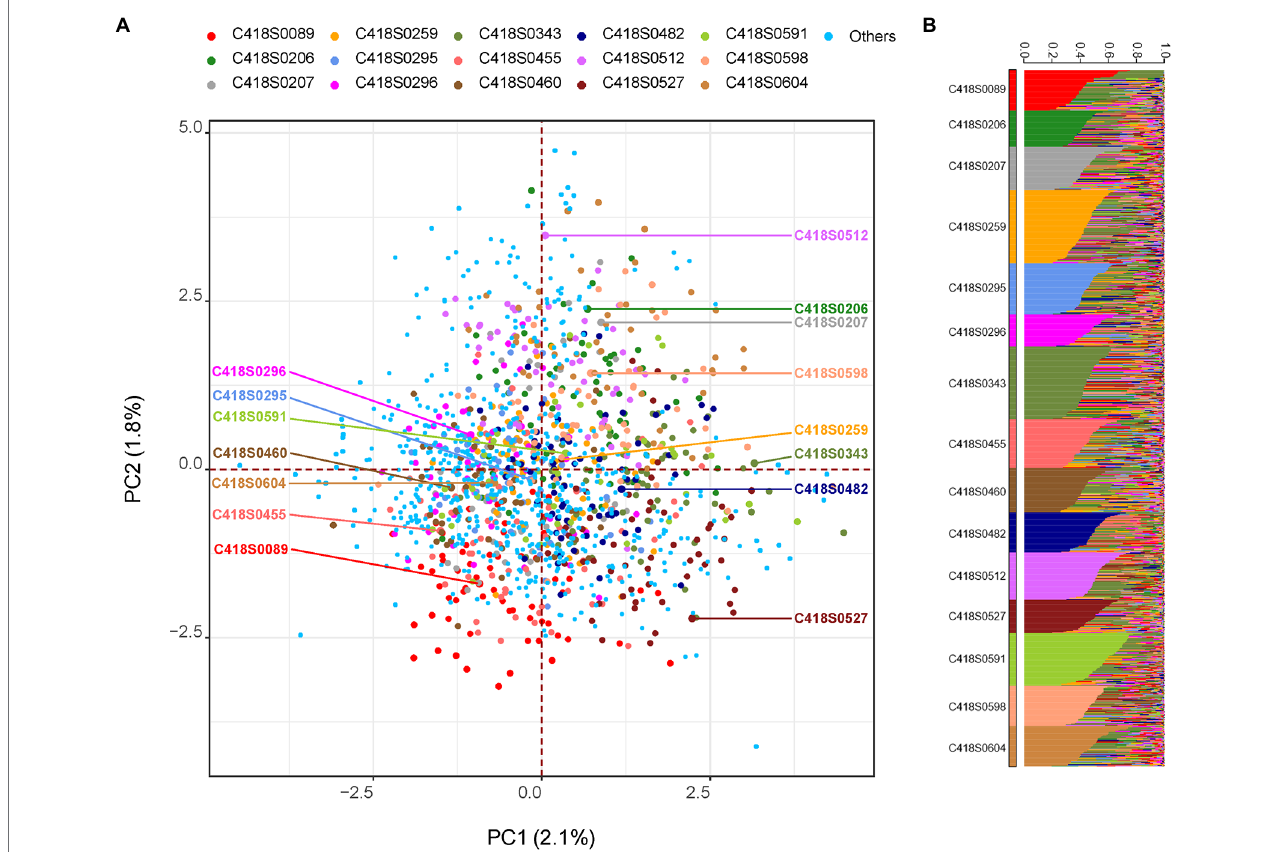
FIGURE 1 | Genetic relationship among the sampled progeny population visualized using: (A) principal component (PC) analysis and (B) STRUCTURE analysis. In Panel (A) , mother genets are labeled with text and progeny sampled from the respective mother genet are highlighted with the same color. All remaining genets in the nursery (including putative paternal genets) are labeled “Others.” In Panel (B) , population structure was inferred using the program STRUCTURE by setting K = 15. The 15 clusters (families) are displayed in ascending order and individuals within each cluster are sorted by Q